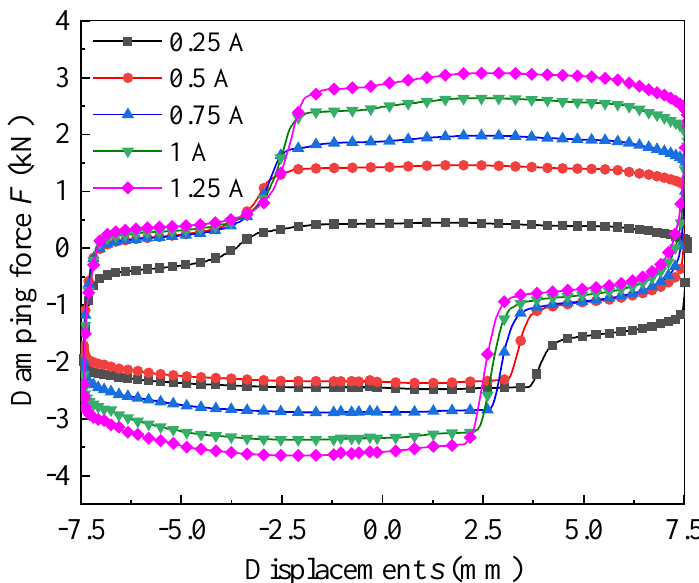
Figure 28. Damping force under different displacements.